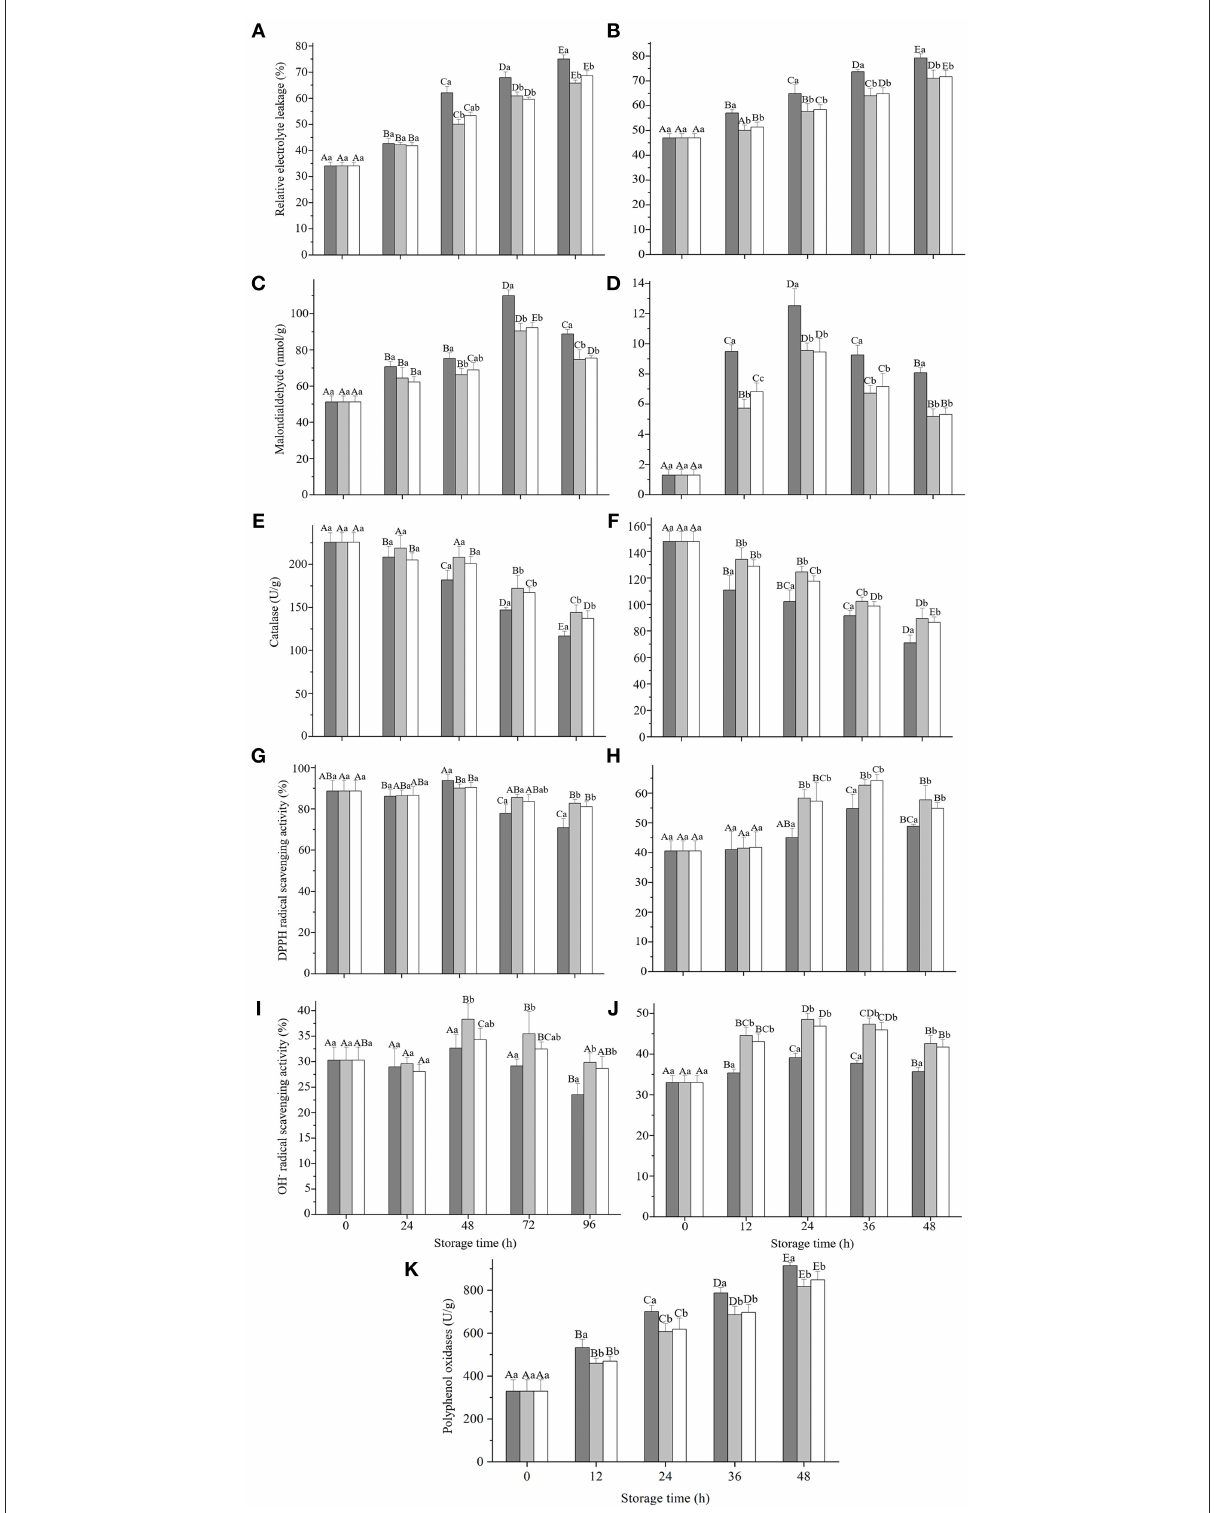
FIGURE5 Changes of relative electrolyte leakage (A,B) , malondialdehyde formation (C,D) , catalase activity (E,F) , DPPH • scavenging activities (G,H) , and OH • scavenging activities (I,J) in strawberry (A,C,E,G,I) and fresh-cut apple (B,D,F,H,J) respectively, and polyphenol oxidases activity of fresh-cut apple (K) during storage at 20 ± 1 ◦ C and a relative humidity of 25 ± 2 % after treatments with deionized water or GRP aqueous solutions. GPR,